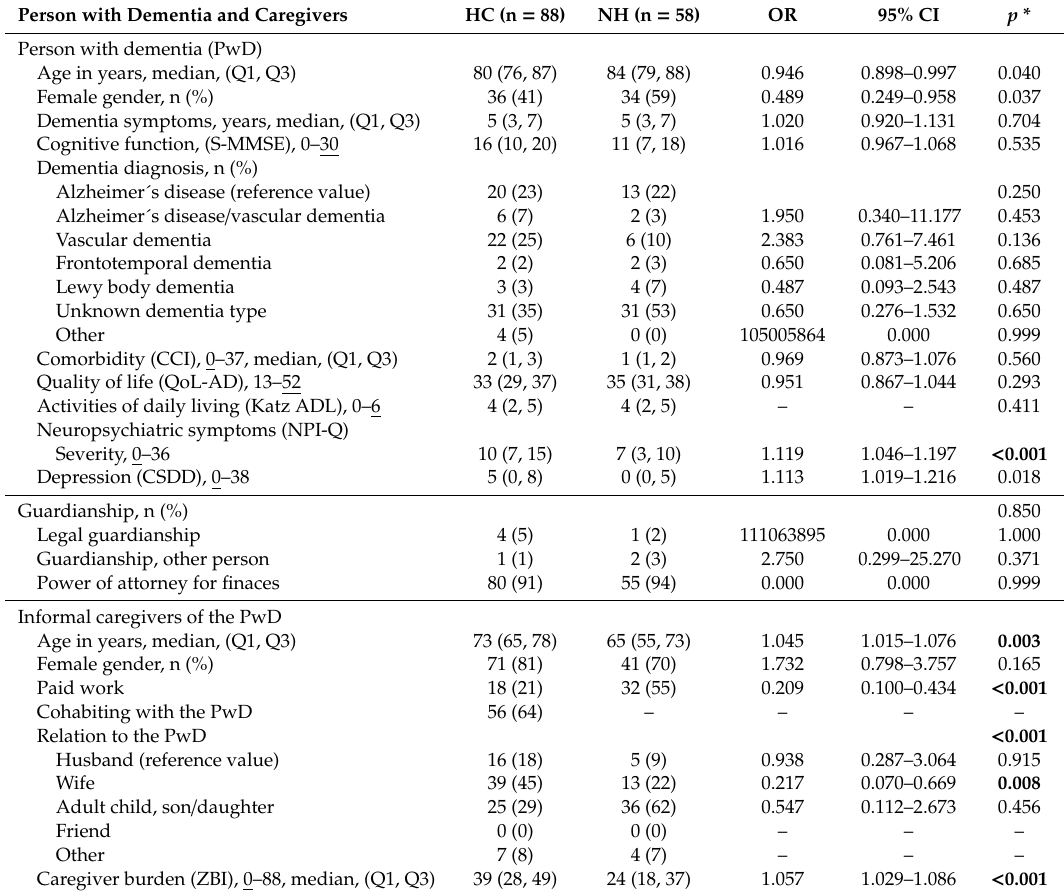
Table 2. Bivariate regression analysis of persons with dementia living in home care versus in a nursing home and their informal